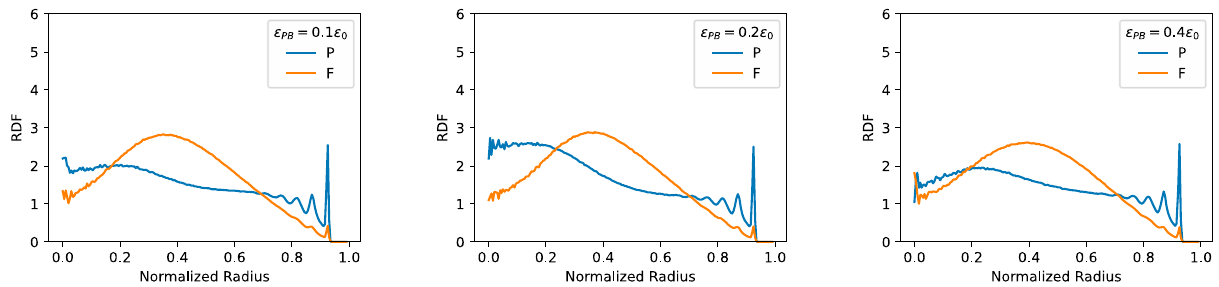
Figure A1. The RDFs obtained from the 1-Chr system with different ε PB values.